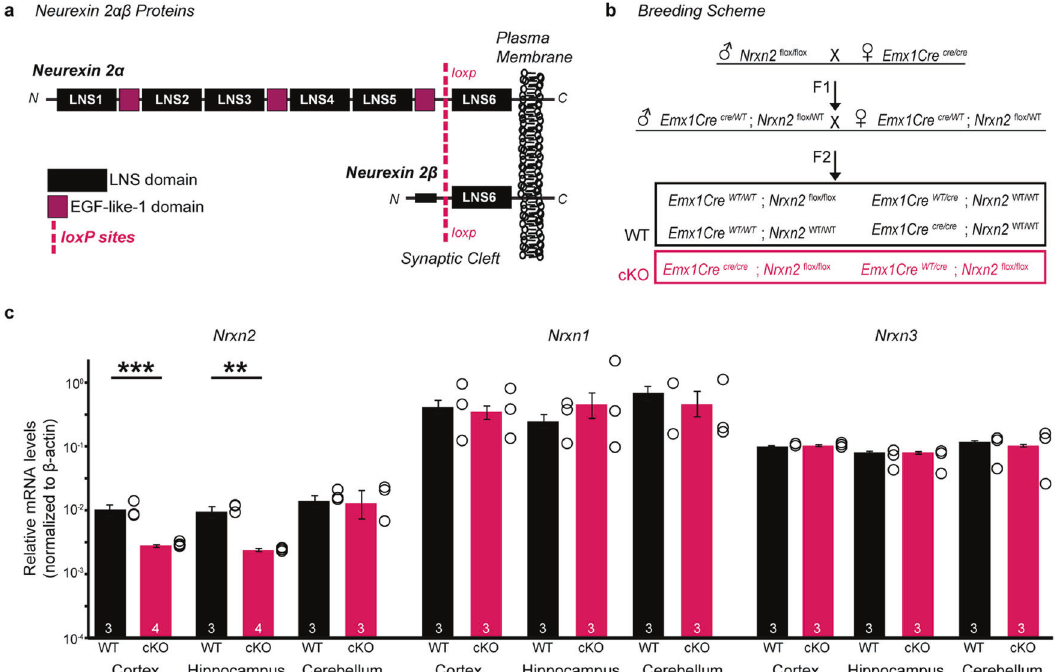
Fig. 1 Emx1Cre driven deletion of Nrxn2 in mouse brain. a Diagram illustrating α - and β - domain structures of Neurexin 2 ( Nrxn2 ) (LNS = laminin/neurexin/sex-hormone binding globulin domain; EGF = epidermal growth factor-like 1 domain). The fi rst exon shared by Nrxn2 α - and β is fl anked by loxP sites ( Nrxn2 fl ox/ fl ox mice). b Breeding scheme for conditional deletion of Nrxn2 ( Nrxn2 cKO) by crossing Nrxn2 fl ox/ fl ox mice with Emx1 cre/cre mice. The fi rst fi lial (F1) generation results in heterozygous offspring, to generate the second fi lial generation (F2). F2 WT and Nrxn2 cKO genotypes are listed: 18.75% of offspring were Nrxn2 cKO while 43.75% were WT. Refer to supplementary Fig 1 and supplementary table 2 for expression levels of Nrxn2 and Emx1Cre across brain regions. c mRNA measurements by qRT-PCR demonstrated that Cre recombinase reduced Nrxn2 expression without altering Nrxn1 or Nrxn3 expression. Summary graphs of relative mRNA levels (normalized to actin) from cortex, hippocampus, and cerebellum. Refer to supplemental Fig1c for qRT-PCR probe alignments. Number of mice is listed inside the bar graphs. Each open circle in the summary graphs represents each mouse. Data is represented as means ± SEM from 3 WT and 4 Nrxn2 cKO for Nrxn2 (c); 3 WT and 3 Nrxn2 cKO for Nrxn1 and Nrxn3 ( c ). Statistical assessments were performed by two-tailed Student ’ s t -test by comparing Nrxn2 cKO to WT mice with ** p < 0.01, *** p <